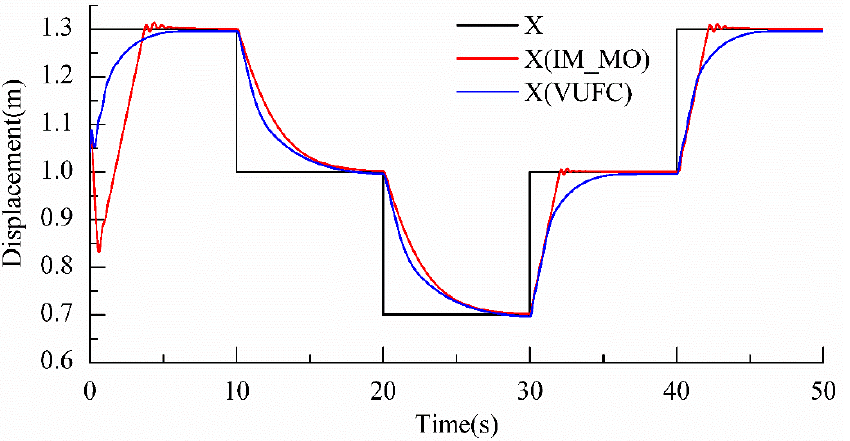
Figure 15. Boom cylinder displacement.